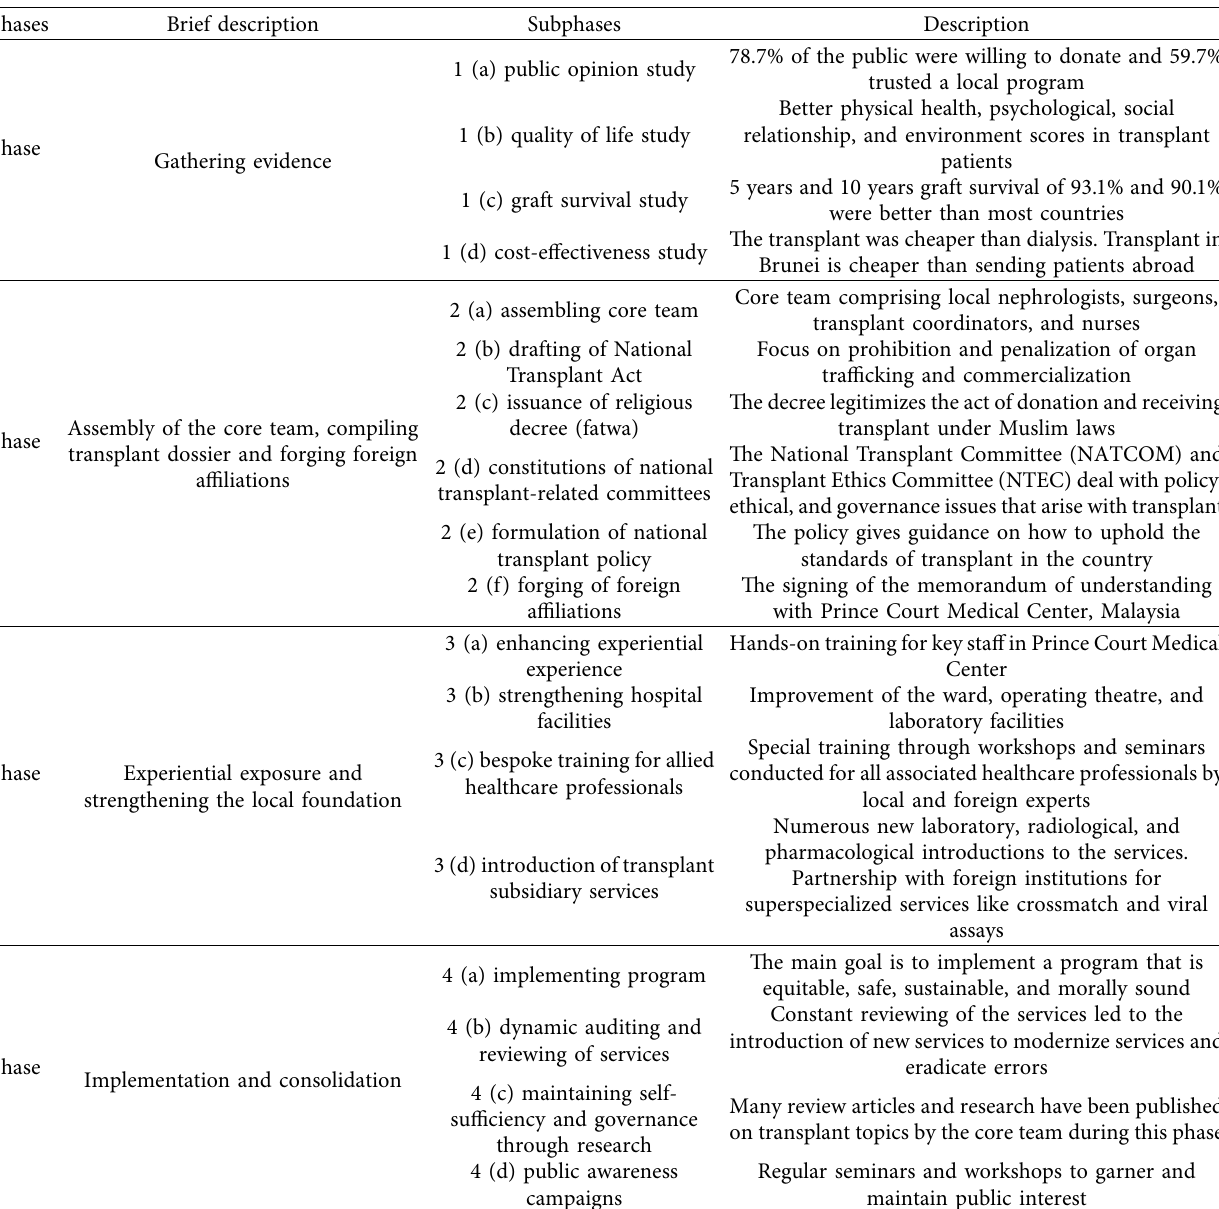
Table 6: Phases of the kidney transplant program in